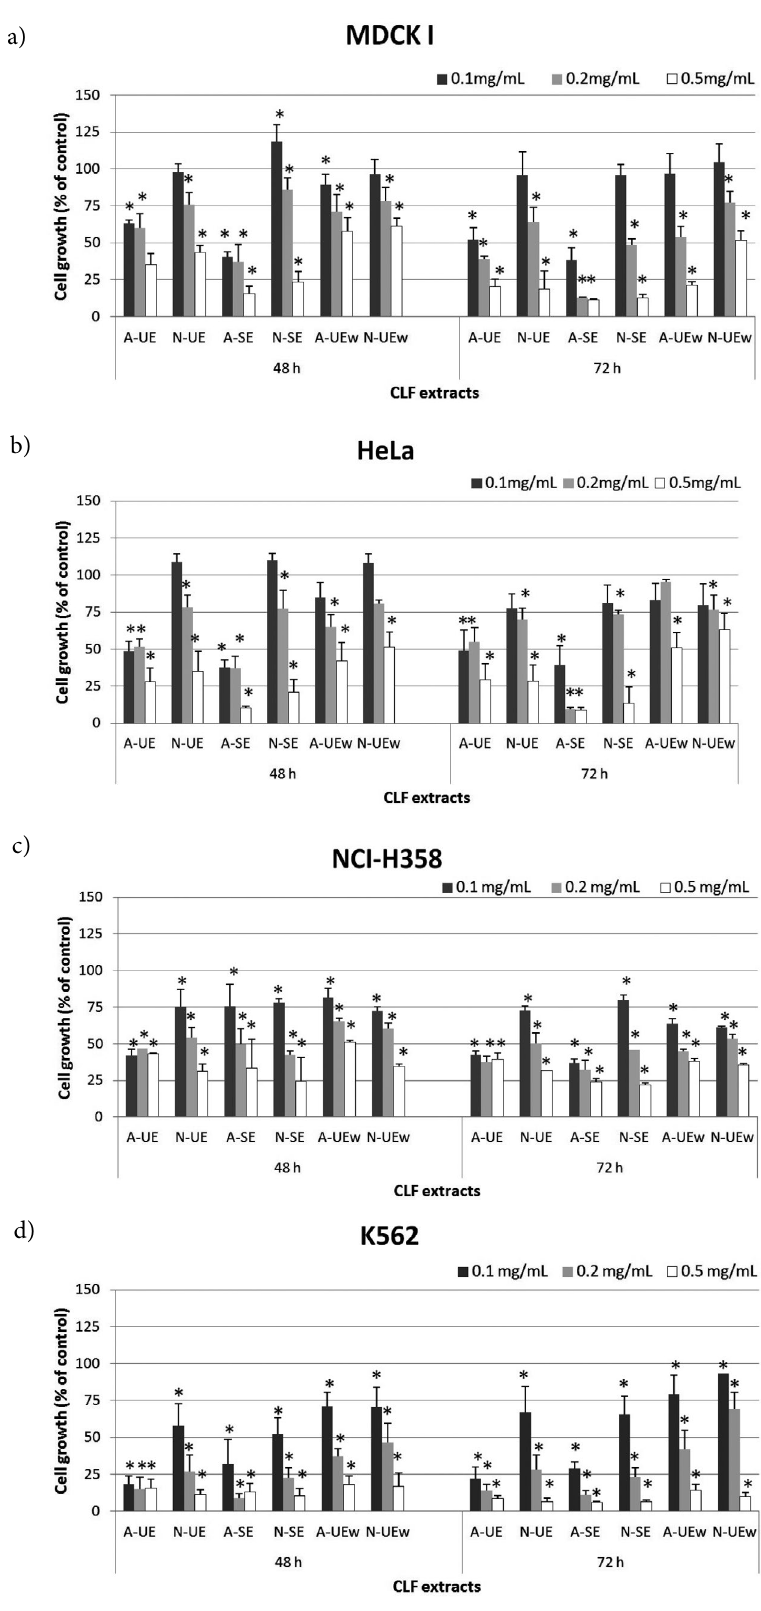
Figure 2. Cytotoxic effect of autofermented and native extracts in different cell lines. MDCK I (a), HeLa (b), NCI-H358 (c) and K562 (d) cells were treated with 0.5, 0.2 and 0.1 mg/mL of extract respectively. Cytotoxicity was assessed after 48 and 72 h by the MTT survival assay. Data represent mean value of three independent experiments done in triplicate. *Statistically significant change (p < 0.05) compared to control (non-treated)